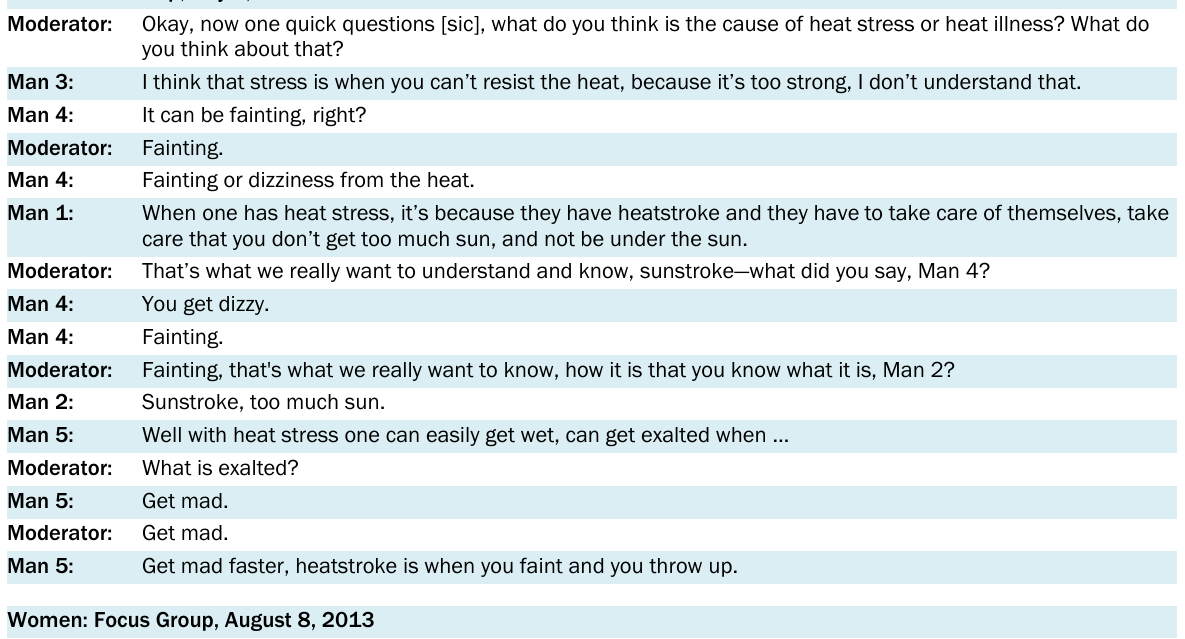
Table 7. Comparison of Symptom Discussion by Gender a Men: Focus Group, July 5,